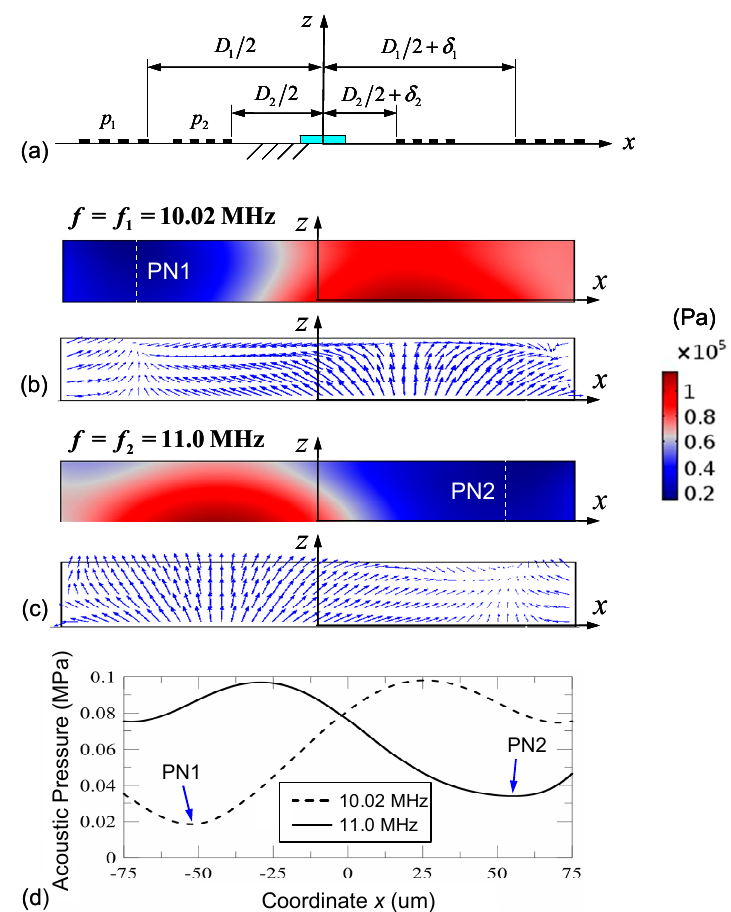
Figure 4. ( a ) Schematic of the two-pitch parallel IDT on the top surface of the LiNbO 3 substrate. The IDT pitches are p 1 = 398 µ m and p 2 = 363 µ m. The translation distances of the right-hand parallel IDT are δ 1 = 25 µ m (rightward) and δ 2 = –29 µ m (leftward) to break the symmetric arrangement and form asymmetric field distributions. Simulated acoustic pressure and ARF fields generated by the SSAW field with the two-pitch parallel IDTs using frequencies of ( b ) f 1 = 10.02 MHz and ( c ) f 2 = 11.0 MHz at a voltage of V 0 = 16 V. ( d ) PN locations and comparison of the acoustic pressure variations using f 1 = 10.02 MHz and f 2 = 11.0 MHz along the width direction of the water domain.